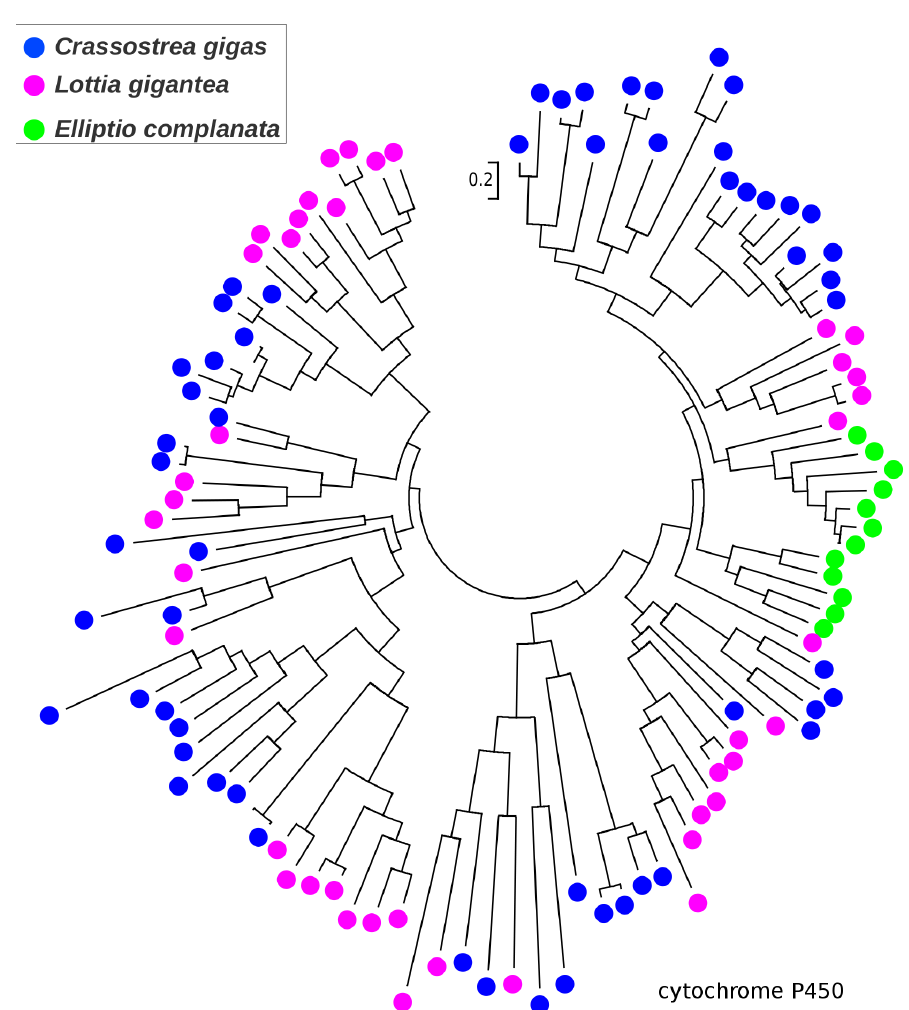
Figure 2. Gene tree of cytochrome P450 sequences from Elliptiocomplanata and two other molluscs suggesting lineage-specific diversification. Trees were rendered in MEGA5 [16] using maximum likelihood and the JTT amino-acid substitution matrix. Bootstrap support was not evaluated because no explicit phylogenetic hypothesis was tested. Multiple-sequence alignment with gene/contig names is provided in fasta format in the supplemental materials. doi:10.1371/journal.pone.0112420.g002 PLOS ONE |